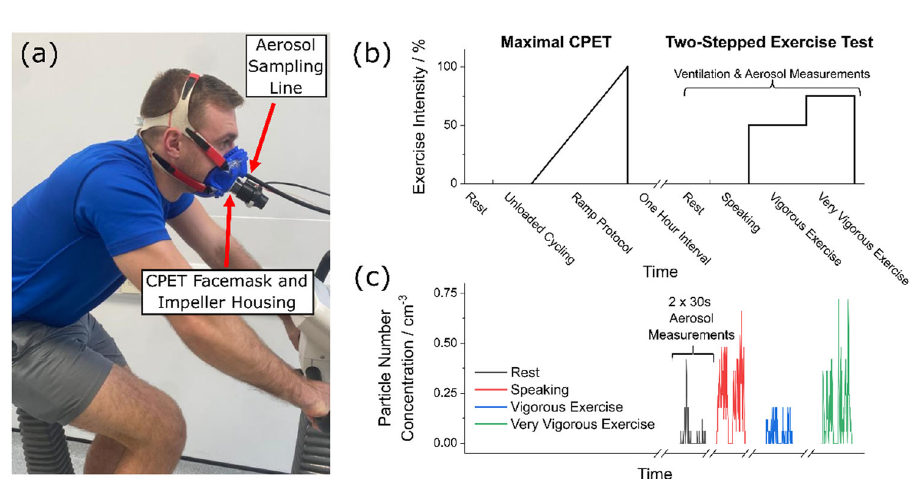
Fig. 1 Experimental setup and study protocol. a Experimental setup: cycle-ergometer-based exercise testing with concurrent ventilatory and aerosol measurements via APS-mask, from sampling line inserted into sampling hole at the tip of the nose. Informed consent for publication of the image was obtained. b Experimental design: maximal CPET followed by a two-stepped exercise test, post 1-h interval. c Typical time series of aerosol number concentration data sampled periodically via APS-mask during the two-stepped exercise test. Horizontal scale adjusted to align with corresponding activities in b . APS aerodynamic particle sizer, CPET Cardiopulmonary exercise